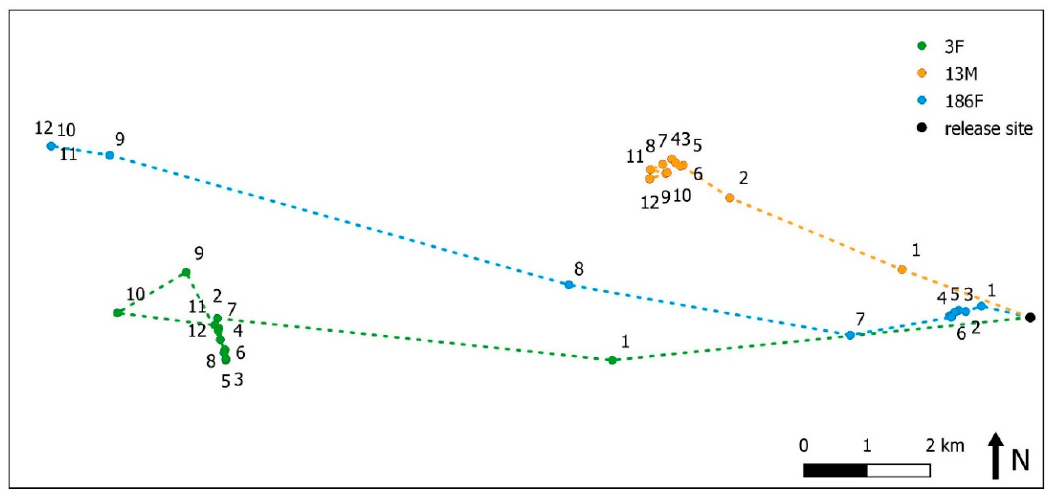
Figure 5. Geometric centre of area occupied for each month post-release for individual kangaroos 13M, 186F and 3F.